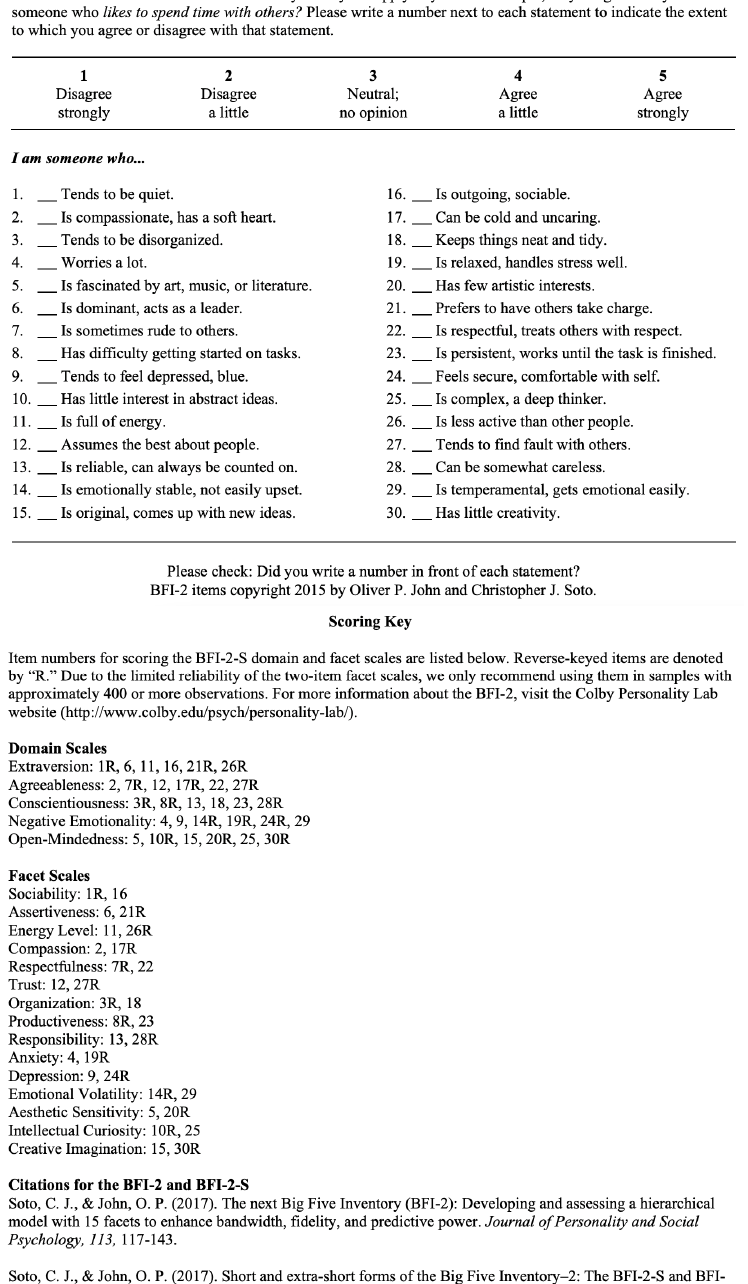
Figure A1. Snapshot of the Big Five Inventory–2 Short Form that was filled out by the